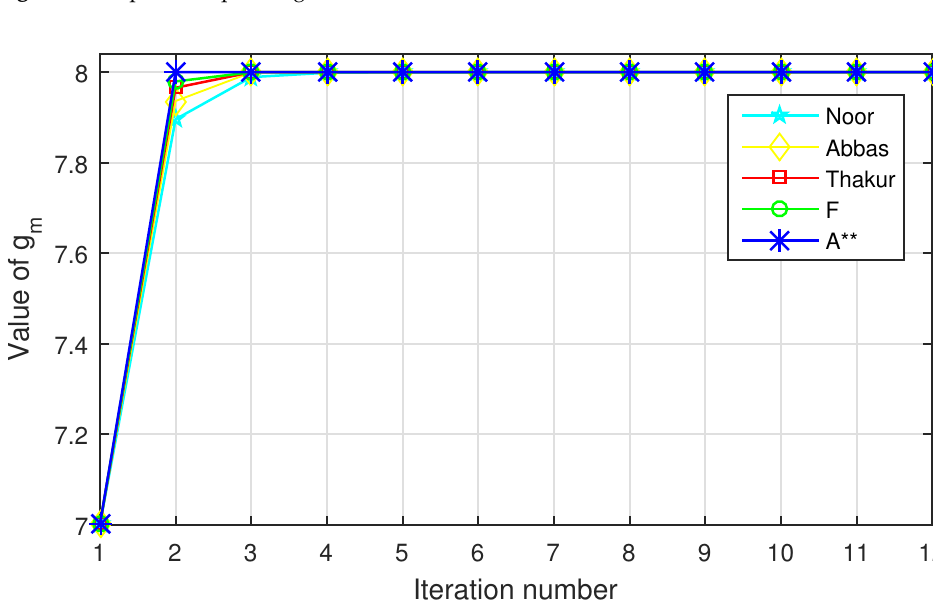
Figure 1. Graph corresponding to Table 1.